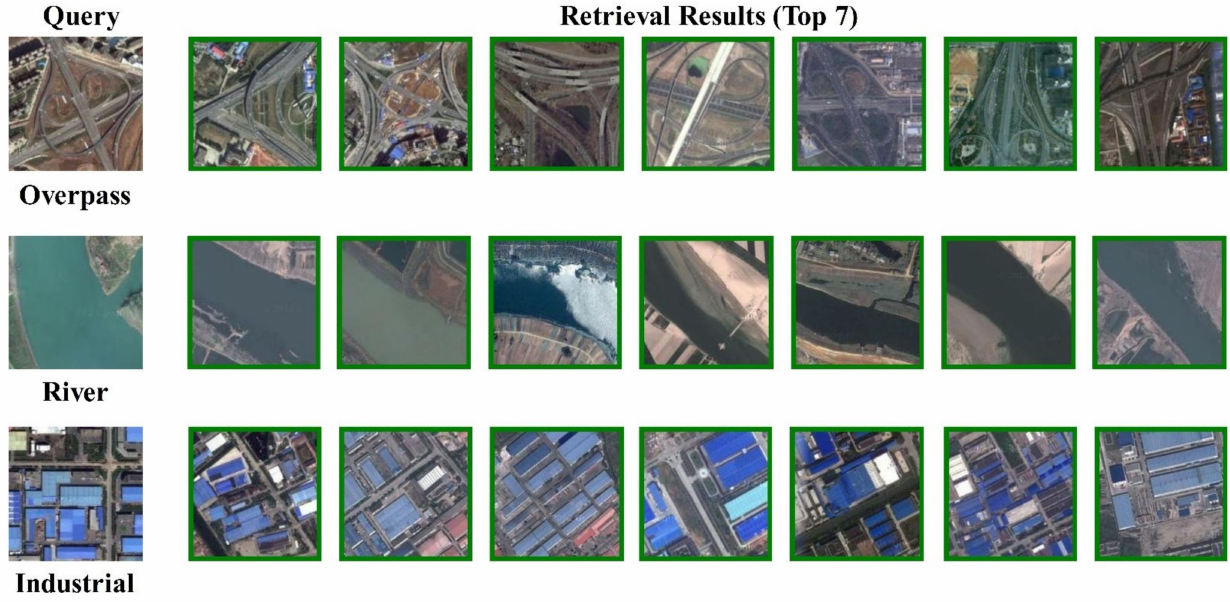
Figure 4. Examples of the retrieval results on UCMD. Each row corresponds to a test case: the query is shown in the first column, and the second to fifth columns are the retrieval results ranked from 1 to 8. For each dataset, the first row represents the results derived from our method, and the second to sixth rows are the results from DCES, BIER, A-BIER, and ABE.